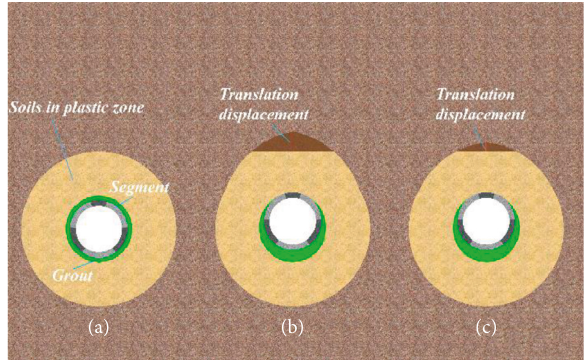
Figure 4: Displacement variation diagram of soil in plastic zone. (a) No floating. (b) Floating (rigid body). (c) Floating (nonrigid